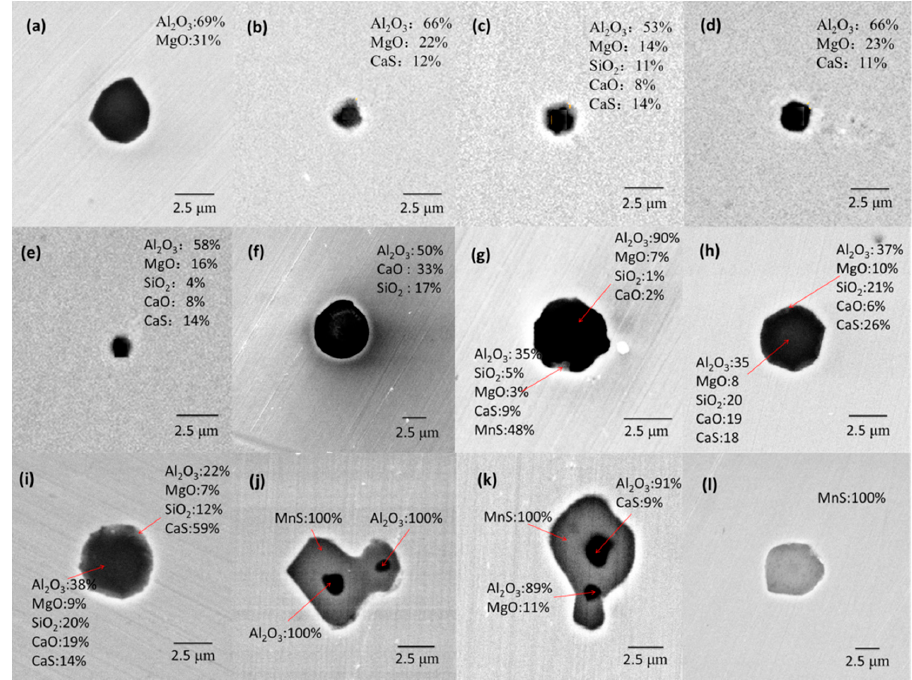
Figure 1. Morphologies and compositions of typical inclusions in samples. ( a – d ) Type-1 inclusions; ( e – h ) Type-2 inclusions; ( i – l ) Type-3 inclusions.